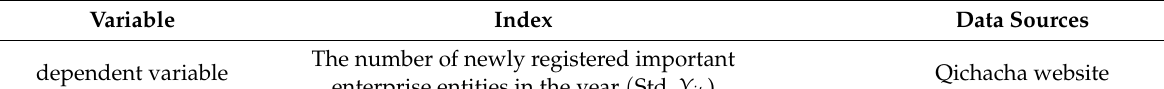
Table 1. Index system and data